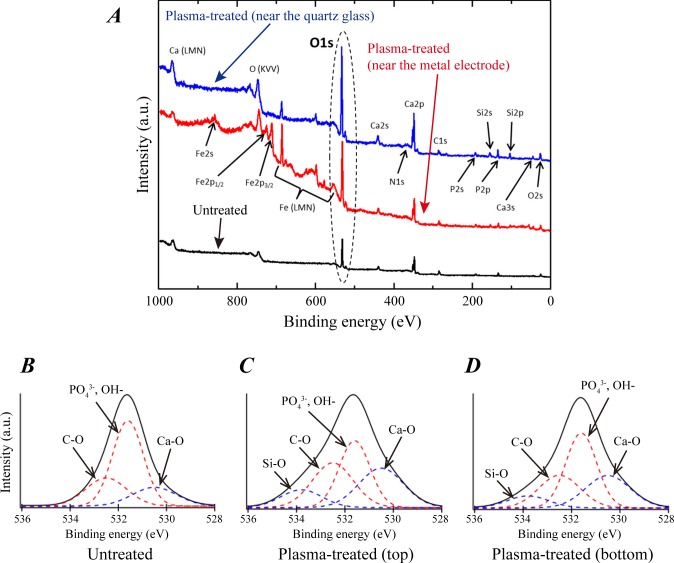
Wide scan XPS analysis of IP-CHA discs.(A) Wide scan spectra. It is seen that the O1s peak of the IP-CHA surface increased notably after plasma treatment (broken oval). The Fe peaks appear on the IP-CHA surface that faced the metal electrode (red), whereas the Si peaks appear after plasma treatment, more significantly so on the surface that faced the quartz glass (blue). (B) ,(C), and (D) are narrow scan spectra of O1s for the IP-CHA surface without plasma treatment, the top surface of an IP-CHA disc with plasma treatment, and the bottom surface of an IP-CHA disc with plasma treatment, respectively. We consider that C is a contaminant and Si comes from the quartz glass wall of the discharge chamber.